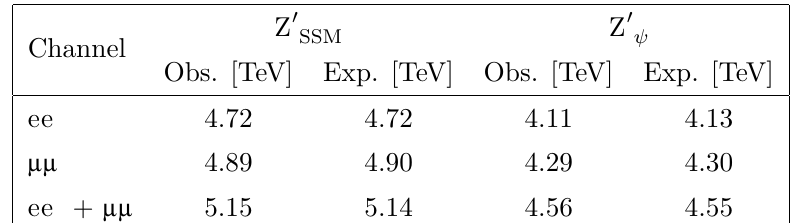
Table 5 . The observed (Obs.) and expected (Exp.) 95% CL lower limits on the masses of spin-1 Z 0 and Z 0 bosons, assuming a signal width of 0.6 (3.0)% of the resonance mass for Z 0 SSM ψ